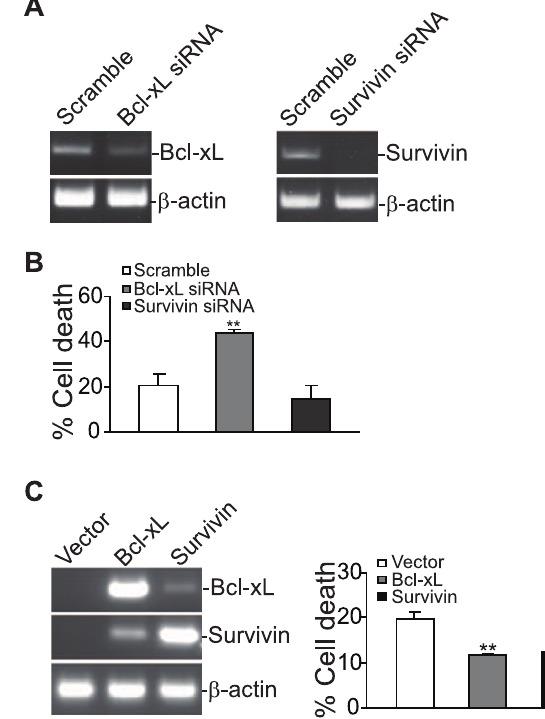
Figure 3. Bcl-xL mediates TRAIL resistance in the metastatic colon carcinoma cells. A . Silencing Bcl-xL and survivin expression by siRNAs. SW620 cells were transiently transfected with scramble or gene- specific siRNAs for approximately 20 h and analyzed for Bcl-xL and Survivin mRNA level by RT-PCR. B . Silencing Bcl-xL but not survivin expression significantly increased the tumor cell sensitivity to TRAIL- induced apoptosis. The scramble and gene-specific siRNA-transfected cells were cultured in the absence or presence of TRAIL protein for approximately 24 h and analyzed for apoptosis. ** p , 0.01. C . Overexpression of Bcl-xL and Survivin decreased the tumor cell sensitivity to TRAIL-induced apoptosis. SW620 cells were transiently transfected with Vector control (Vector), Bcl-xL-expressing (Bcl-xL) or Survivin-expressing (Survivin) plasmids for approximately 20 h. The cells were then analyzed for Bcl-xL and Survivin mRNA level by RT-PCR (left panel). The cells were also treated with IFN- c and TNF a for 4 h, followed by incubation with TRAIL protein for approximately 24 h and analysis for apoptosis by PI staining and flow cytometry analysis (right panel). ** p ,